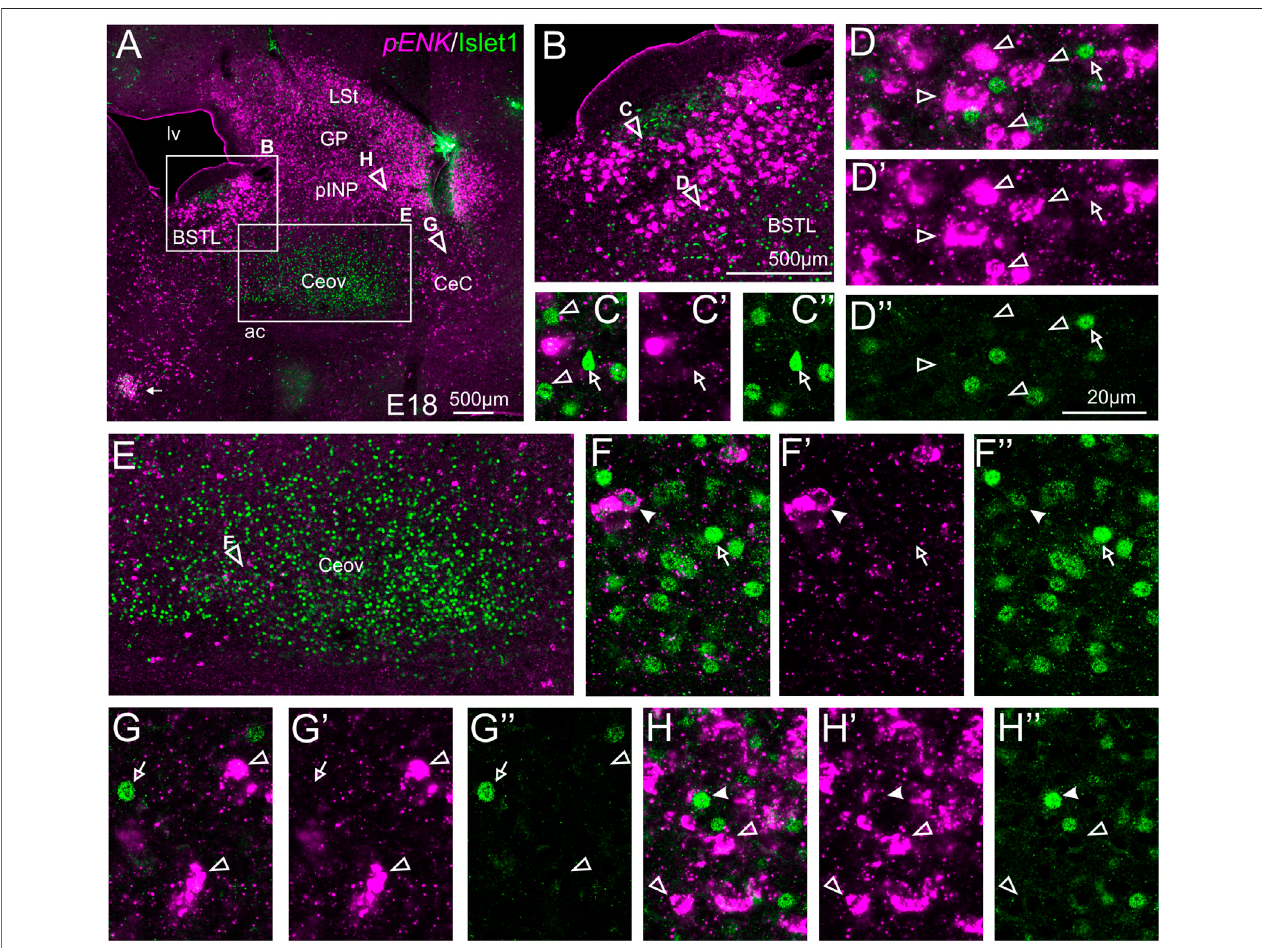
FIGURE 3 | Double fl uorescence labeling of pro-ENK ( pENK ) and Islet1 in the chicken central extended amygdala at E18. (A) General view (10X objective) of the subpalliuminafrontalsectionattheleveloftheanteriorcommissure,processedforindirect fl uorescent insitu hybridizationfor pENK (magenta)andimmuno fl uorescence for Islet1 (green). (B,E) show ampli fi cations of the squared areas in (A) , at the level of the BSTL (B) and Ceov (E) . Details (×40 objective, only one single z level of the confocal stack) of the areas pointed with arrowheads in (B,E) are shown in (C – C 99 ) (for medial zone of BSTL), (D – D 99 ) (for intermediate zone of BSTL), (F – F 99 ) (for Ceov). Additional details of the areas pointed with arrowheads in A are shown in (G – G 99 ) (for CeC) and (H – H 99 ) (for pINP) (merged plus separate magenta and green channels are shown). In these details, cells coexpressing pENK and Islet1 are pointed with a fi lled arrowhead, cells single labeled for pENK are pointed with an empty arrowhead, while cells single labeled for Islet1 are pointed with an empty arrow (only a few examples are pointed). See text for more details. For abbreviations see list. Scale bars: (A) = 500 μ m; (B) = 500 μ m [applies to (B,E) ]; (D 99 ) = 20 μ m [applies to (C – C 99 ,D – D 99 ,F – F 99 ,G – G 99 ,H – H 99 ) ].